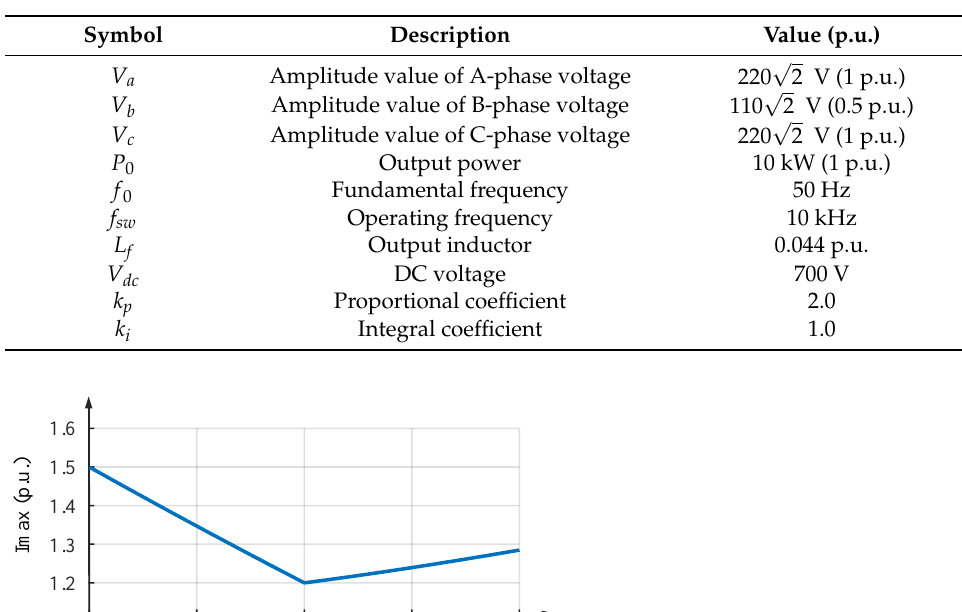
Table 2. Operating parameters of main circuit used in simulations.